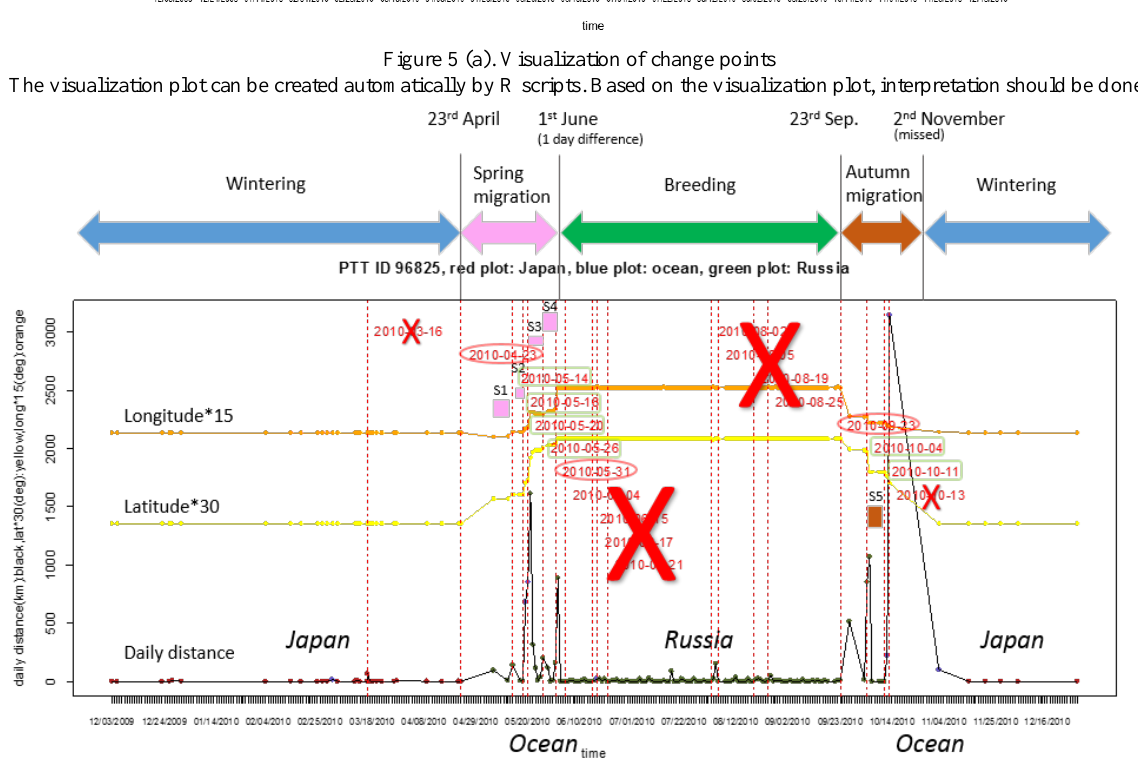
Figure 5 (b). Interpretation of change